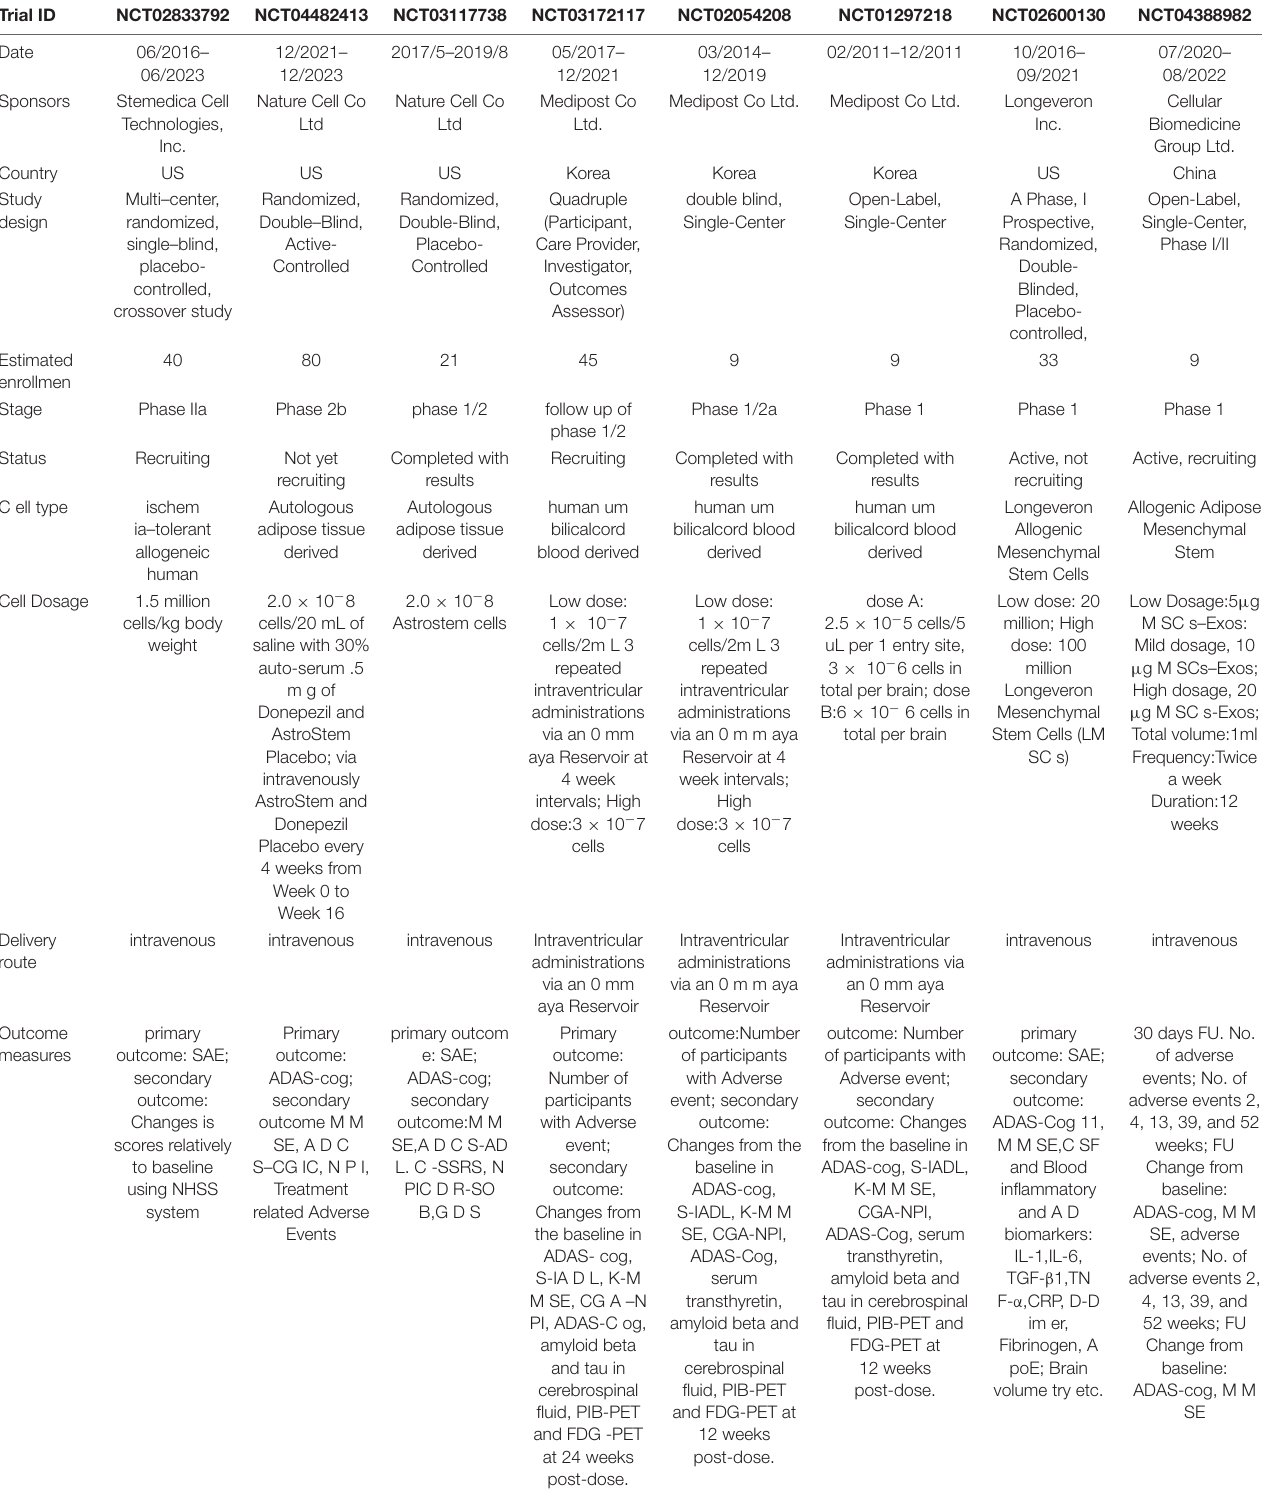
TABLE 1 | Major MSCs clinical trials for